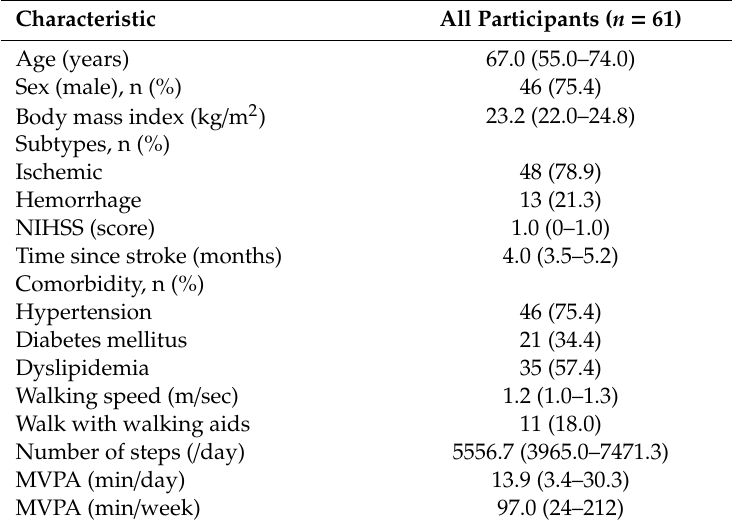
Table 1. Clinical characteristics.